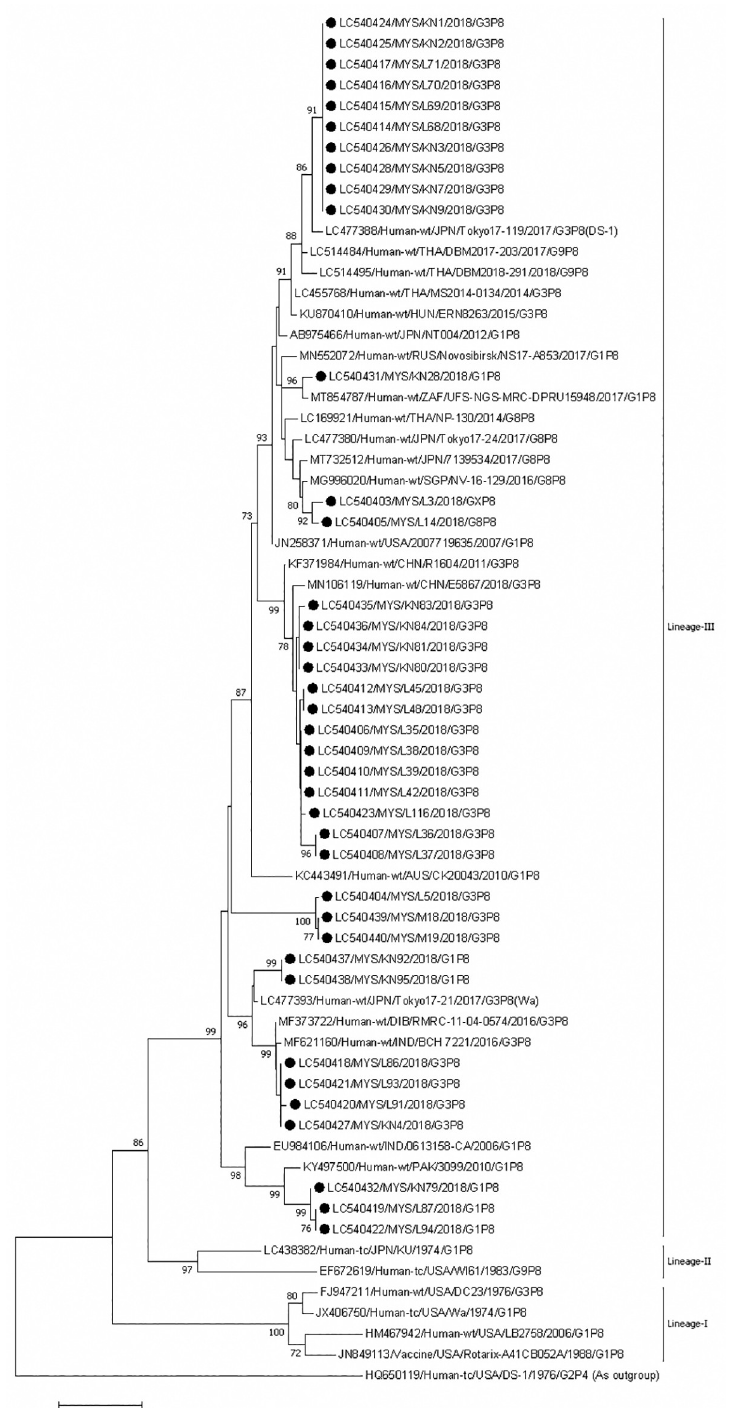
Fig 7. Phylogenetic tree constructed with the nucleotide sequences of the VP4 gene of P[8] strains. Human rotavirus DS-1 (P[4]) was used as an outgroup. The number adjacent to the node represents the bootstrap value and values lower than 70% have not been indicated. Scale bar shows genetic distance expressed as nucleotide substitutions per site. The strains identified in this study are marked with a filled circle. All strains from Sabah belong to lineage III. The nucleotide sequences of our strains have been submitted to the databases of the DNA DataBank of Japan, the European Molecular Biology Laboratory, and GenBank. The accession numbers are shown at the beginning of each